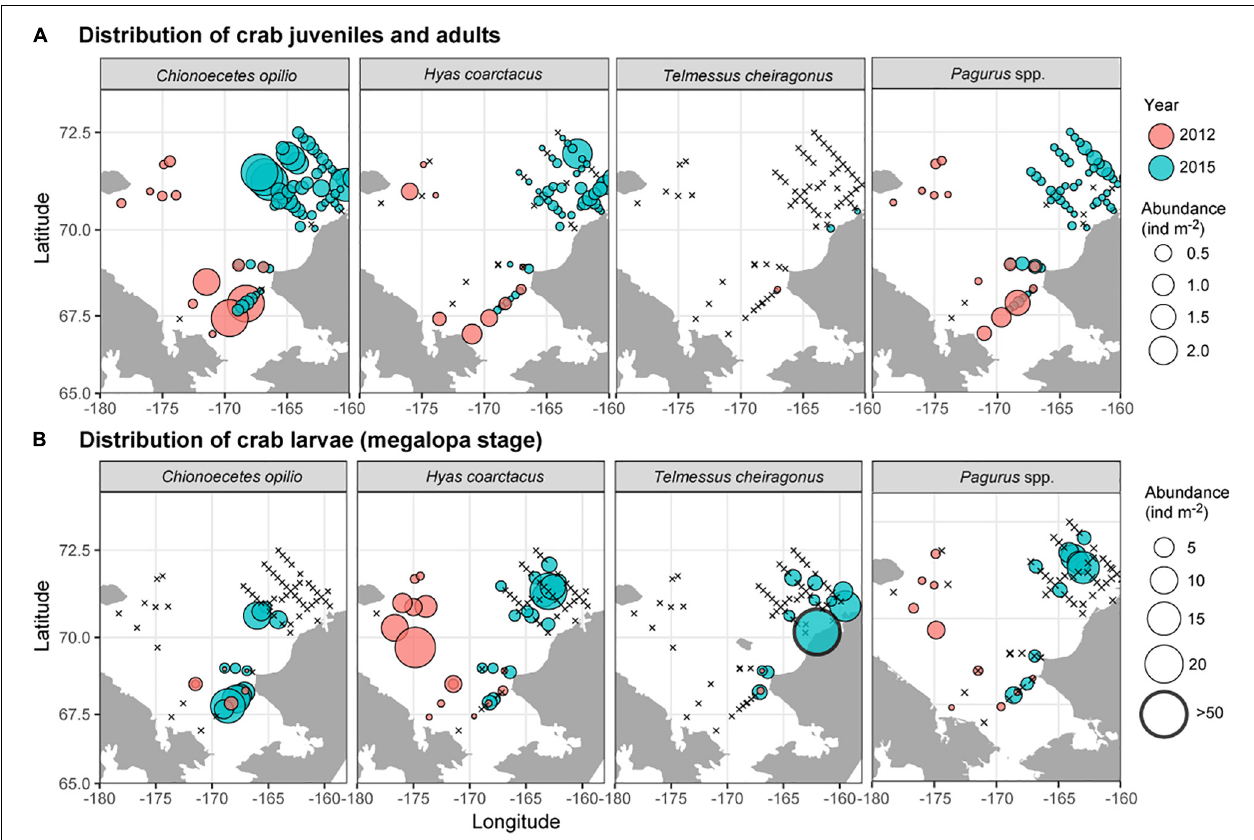
FIGURE 8 | Distribution and abundance of (A) crab and hermit crab juveniles and adults, and (B) crab and hermit crab megalopa during 2012 and 2015 based on Bongo 505 µ m collections.